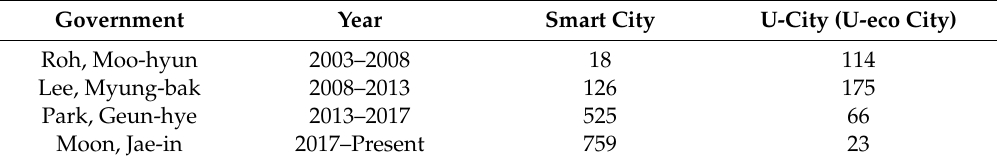
Table 3. Use of terms ‘Smart City’ and ‘U-eco City’ by governments.